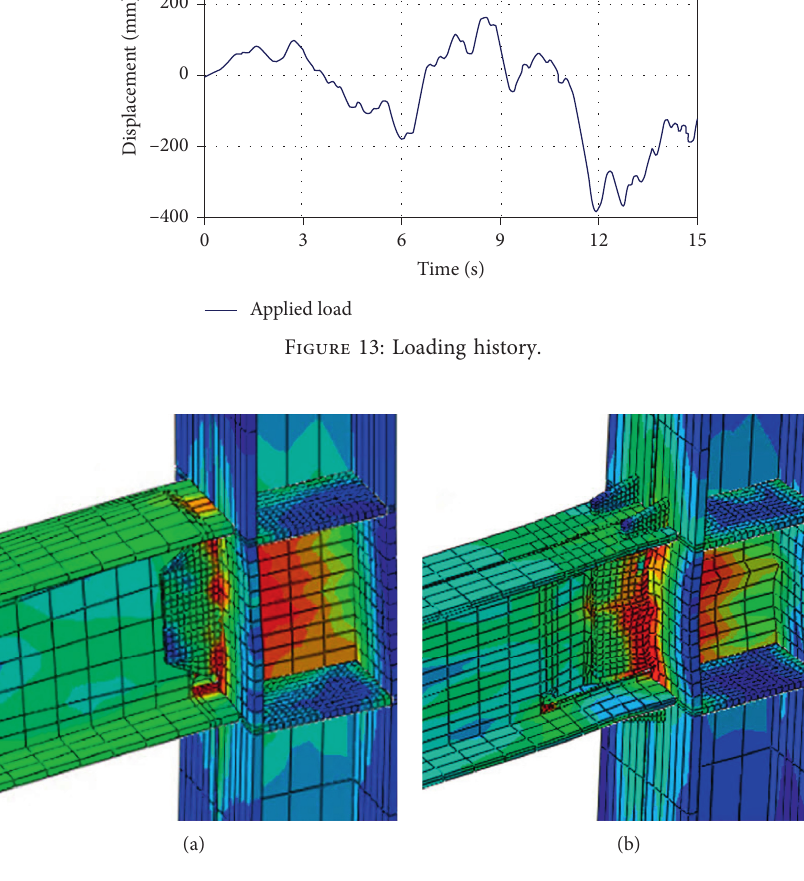
Figure 14: WUF (a) and SW (b) connections in the frame.